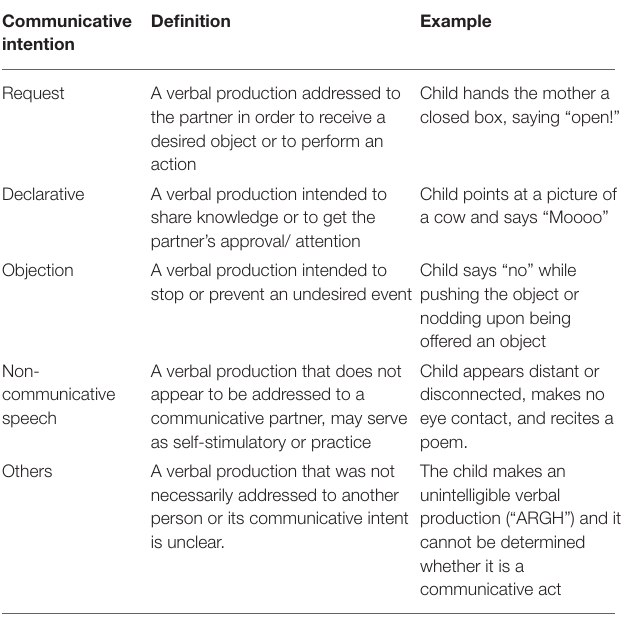
TABLE 1 | Definitions for pragmatic